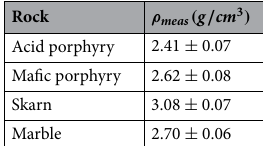
Table 1. Laboratory measured density values ( ρ meas ) of rock samples taken in the Temperino tourist tunnel.